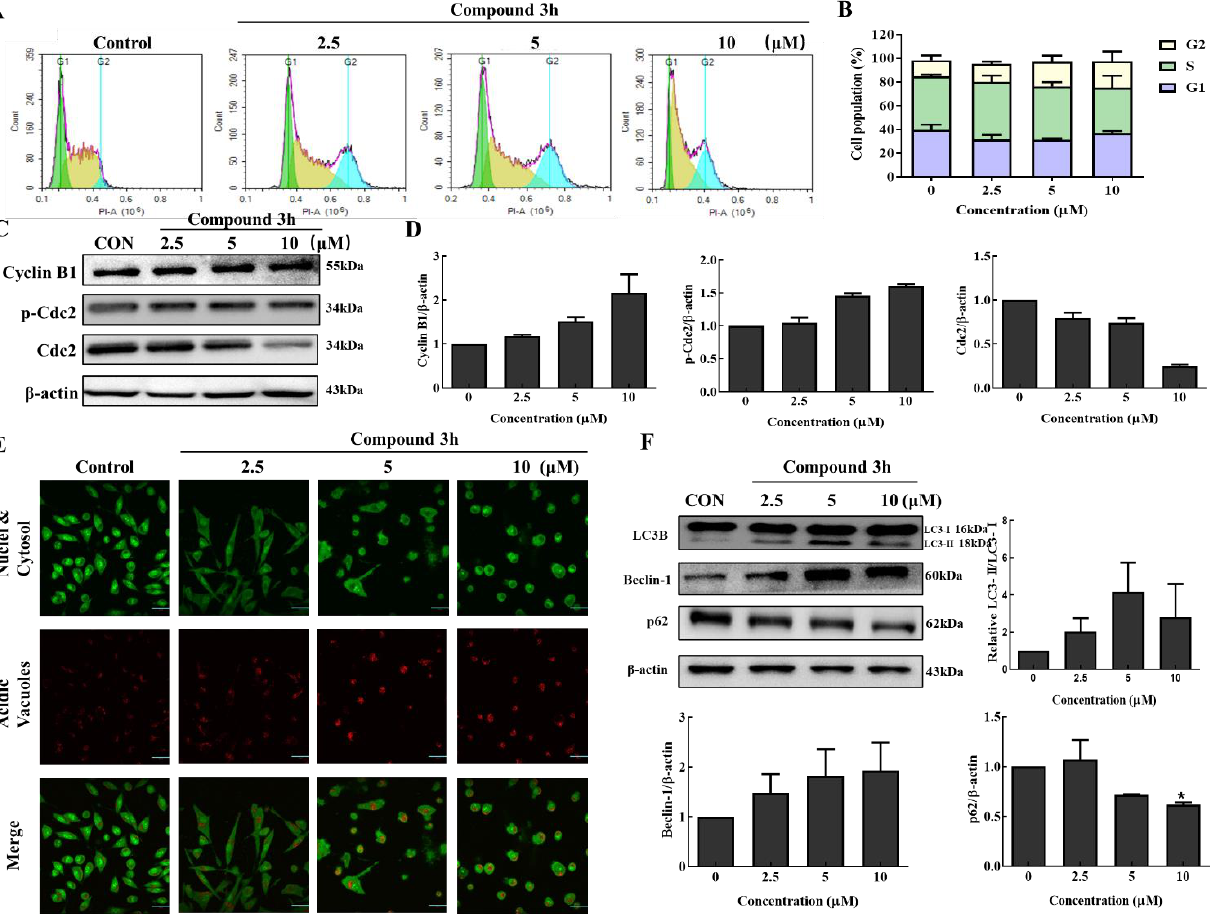
Figure 7. Compound 3h induces G2/M arrest and autophagy in LNCaP cells. ( A ) Cell cycle results of LNCaP measured by NovoCyte after treating compound 3h (0, 2.5, 5, and 10 μM). ( B ) Bar graph indicates the cell population involved in G1, S, and G2/M phases in LNCaP cells after compound 3h treatment. ( C ) Expression changes in G2/M arrest-related proteins (Cyclin B1, p-Cdc2, Cdc2) in LNCaP cells after compound 3h treatment. ( D ) Representative histogram showing the expression levels of Cyclin B1, p-Cdc2, Cdc2, compared to β -actin in LNCaP. ( E ) Autophagy activation was clearly observed in LNCaP cells after compound 3h treatment. Red fluorescence intensity of autophagic vacuoles was observed in compound 3h -treated group in a concentration-dependent manner (Magnification 600×). ( F ) Expression of autophagic proteins in LNCaP cells after compound 3h treatment and LC3- Ⅱ /LC3- Ⅰ , relative Beclin-1, and relative p62 were calculated and shown as graphs. The values represent the mean ± SD. * p < 0.05. The uncropped blots are shown Supplementary Material.